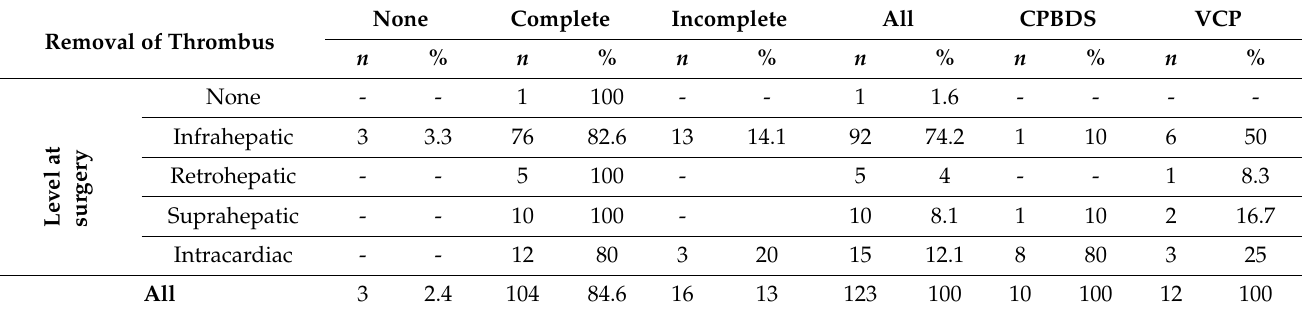
Table 3. Results of surgical resection of the thrombus out of the inferior vena cava ( n = 123, p =